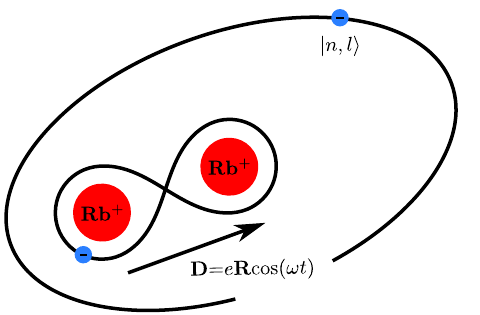
Fig. 8 Rydberg quasi-molecular diatomic complex. The short-range dynamics of the collision between a Rydberg atom and a ground state atom can be described in the framework of a short-lived Rydberg quasi-molecular complex, where tunneling of the inner valence electron between the two ionic cores leads to an oscillating dipole moment D. As a result, the oscillating dipole induces transitions of the Rydberg electron.